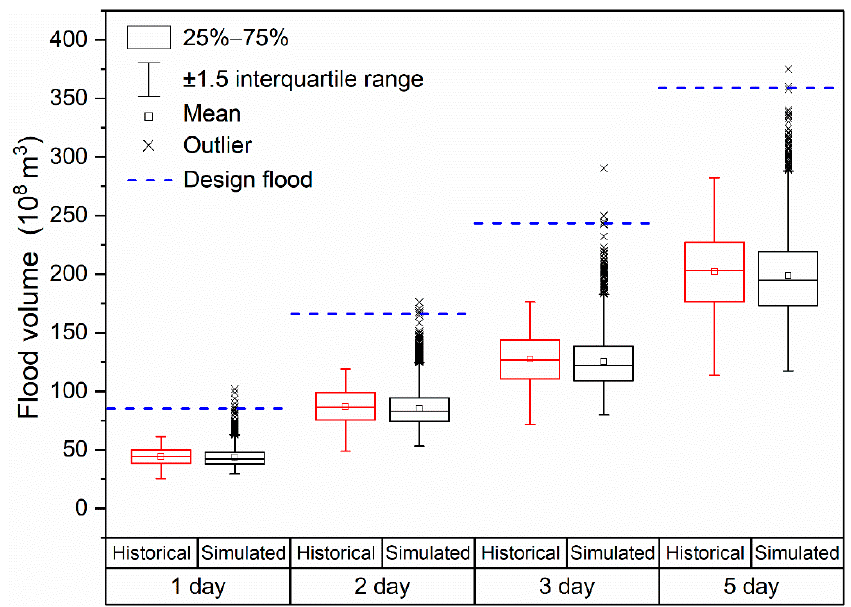
Figure 4. Boxplots of (red) 126 historical annual maximum period flows (1 day, 2 day, 3 day, 5 day) and (black) 10,000 simulated forecast floods, the blue line marks the designed 1000 year return interval flood.